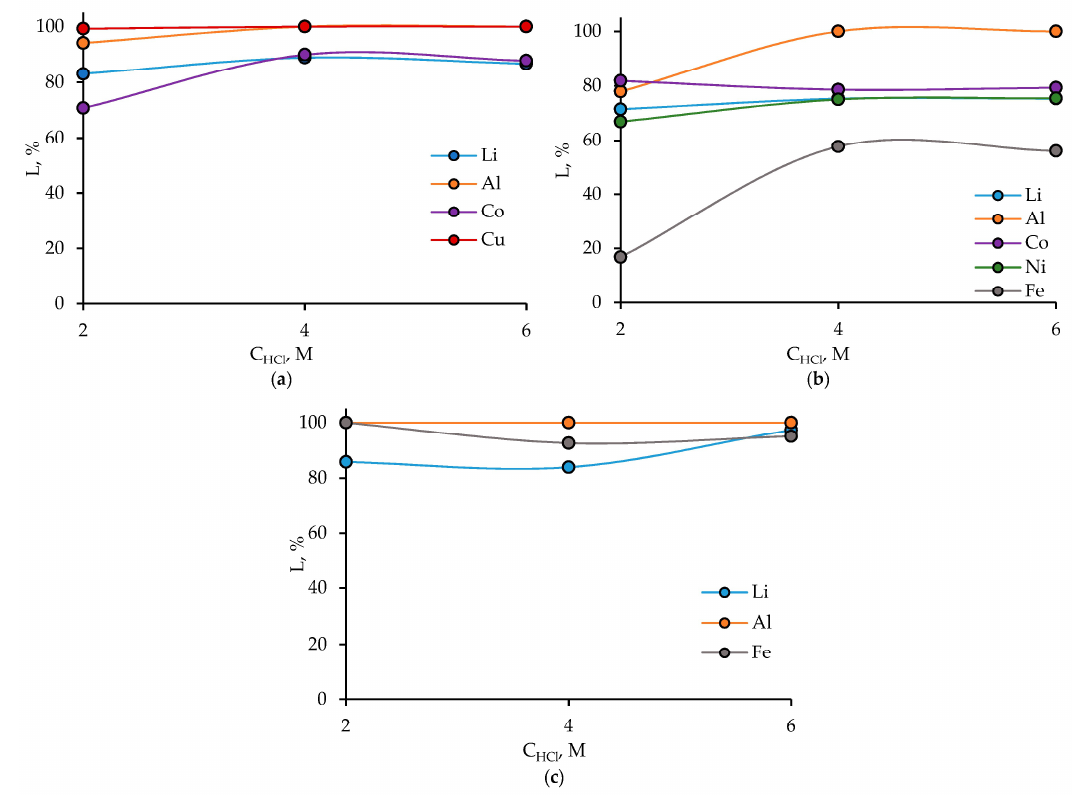
Figure 3. Dependence of the metal leaching degree on the hydrochloric acid concentration, T = 80 ◦ C, t = 60 min: ( a )—LIB 1, ( b )—LIB 2, ( c )—LIB 3.